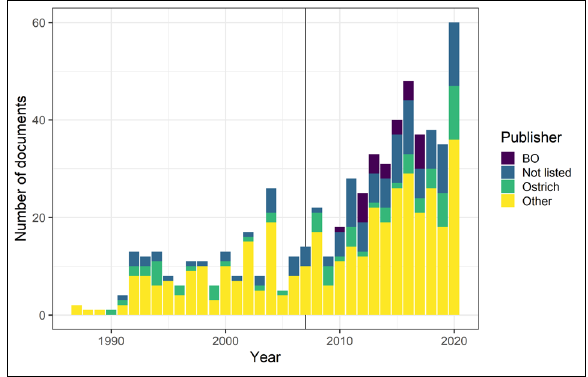
keywords. The vertical line indicates the initiation of SABAP2 in